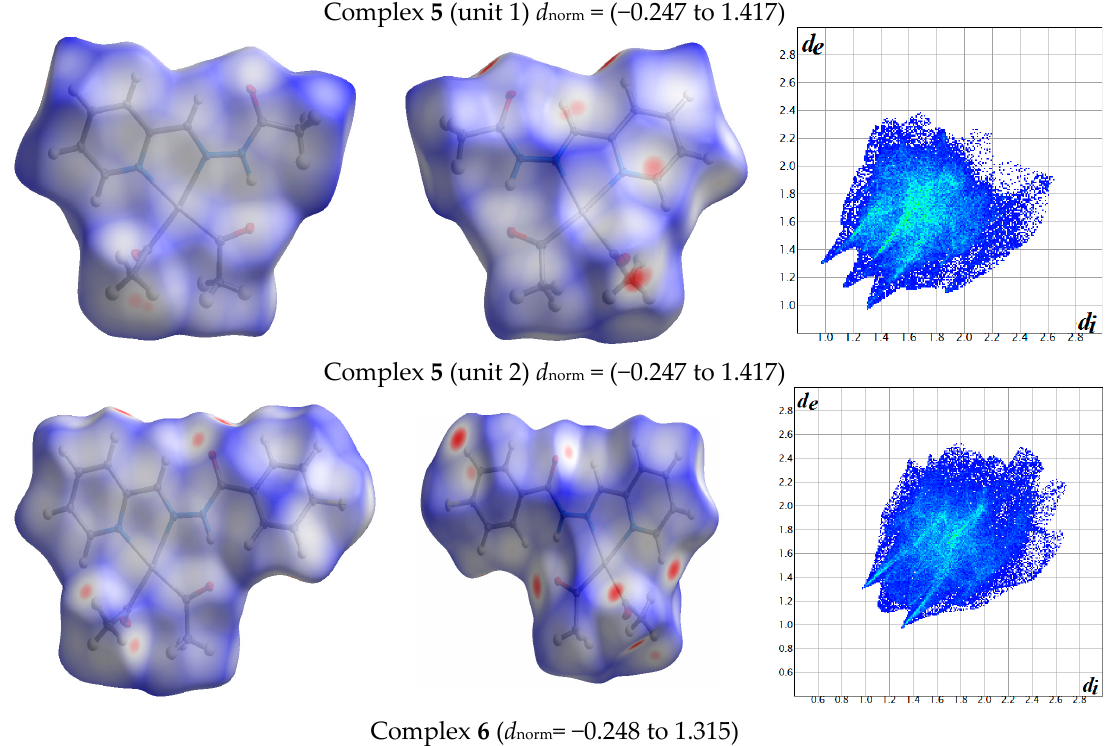
Figure 2. Hirshfeld surfaces and full fingerprint plots of the studied complexes; front views are referred to Figure 1.